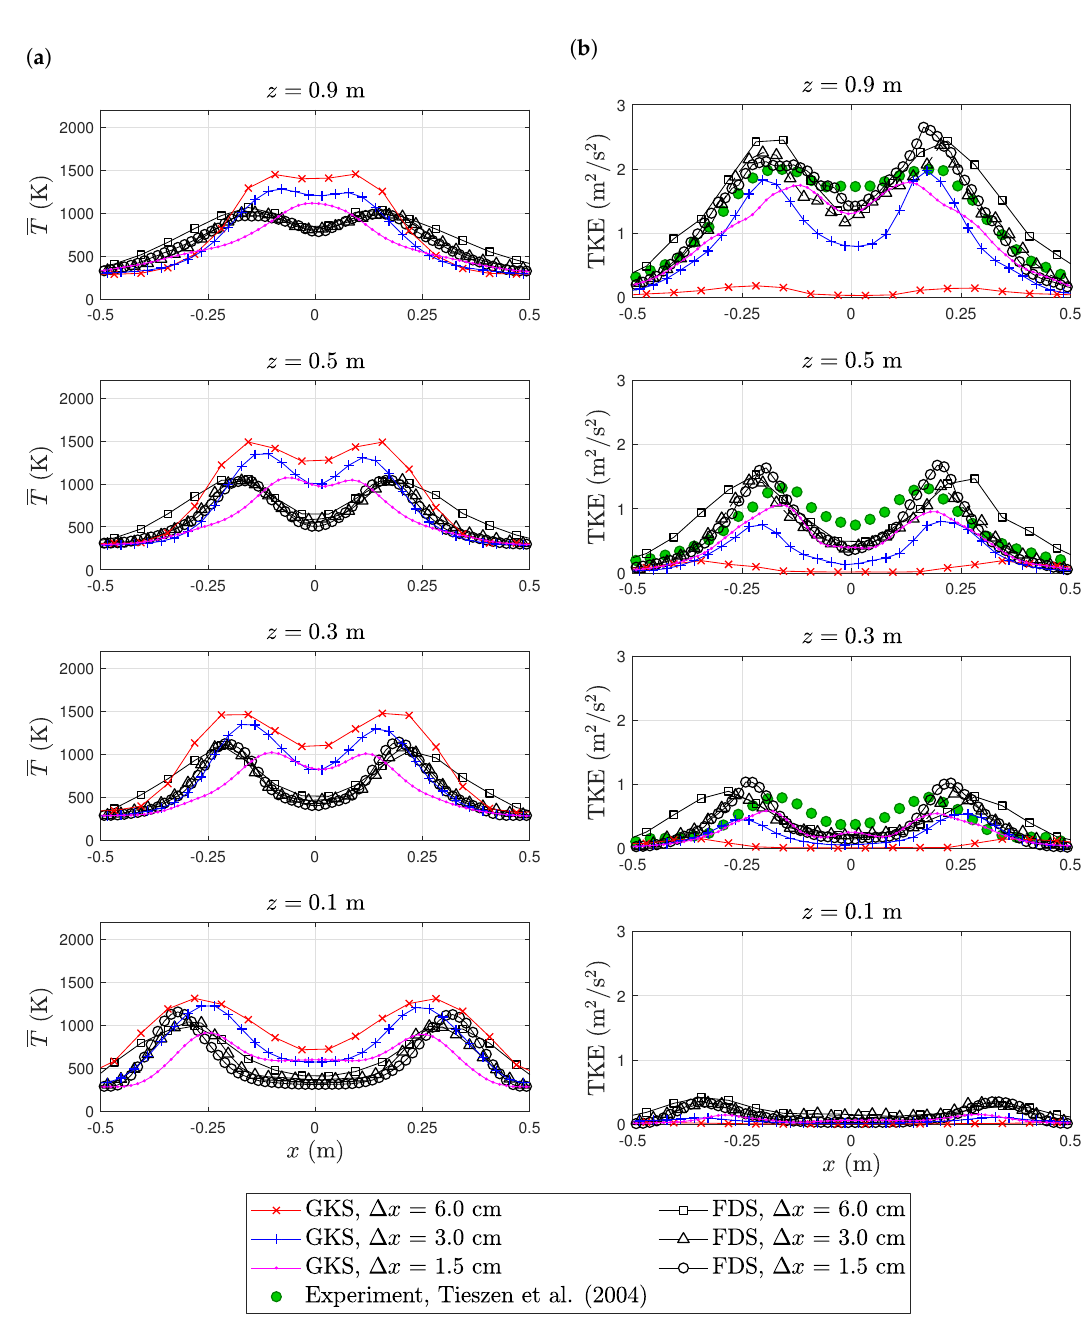
Figure 13. Sandia flame, Test 24: temperature ( a ) and turbulent kinetic energy ( b ) profiles. The experimental data are available online at https://github.com/firemodels/exp/tree/master/